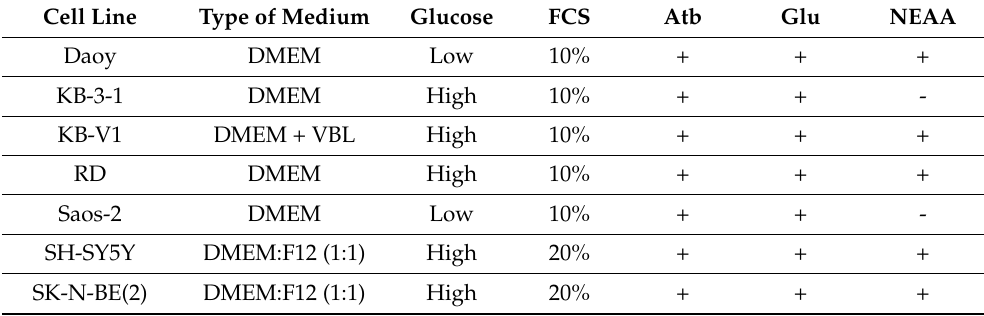
Table 3. Composition of culture media used for culturing the selected cell